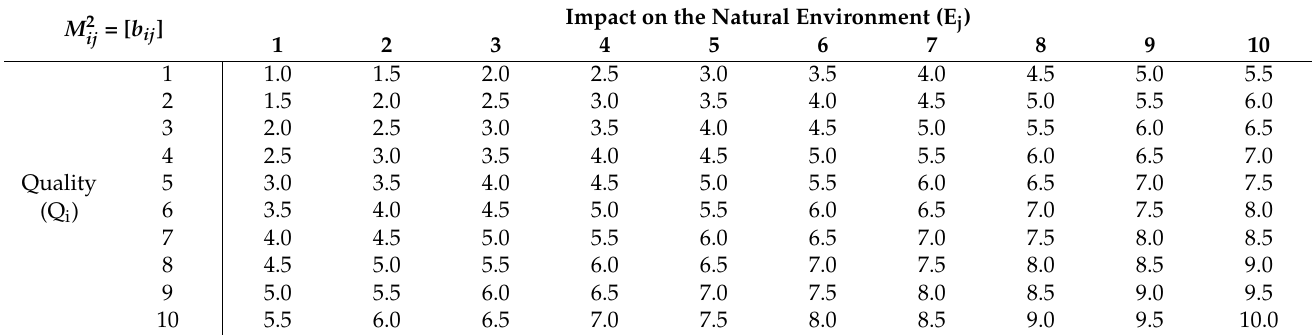
Table 6. Quotient of the sum of assessments and two cumulative assessments of quality and environ- mental impact.